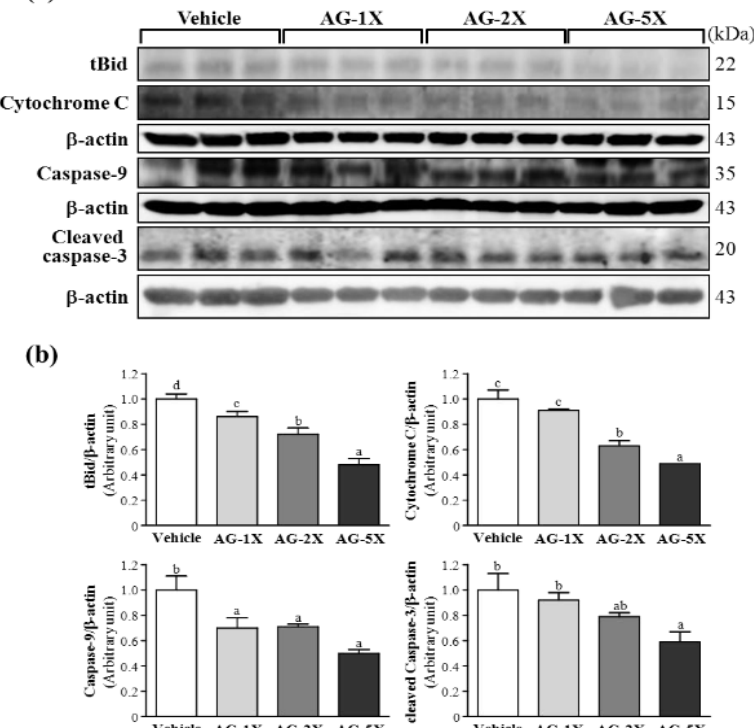
Figure 5. Effect of AG supplementation on ethanol-induced expression of apoptosis proteins in rat stomachs. Rats were treated as in Figure 4. ( a ) Western blot analysis and quantification of protein levels of tBid, cytochrome C, caspase-9 and cleaved caspase-3 in gastric tissues; and ( b ) Densitometry analysis was performed to quantify the expression levels of detected proteins. Data are mean ± SEM (n = 8 mice per group). Different letters (a, b, c, d) indicate a significant difference at p <